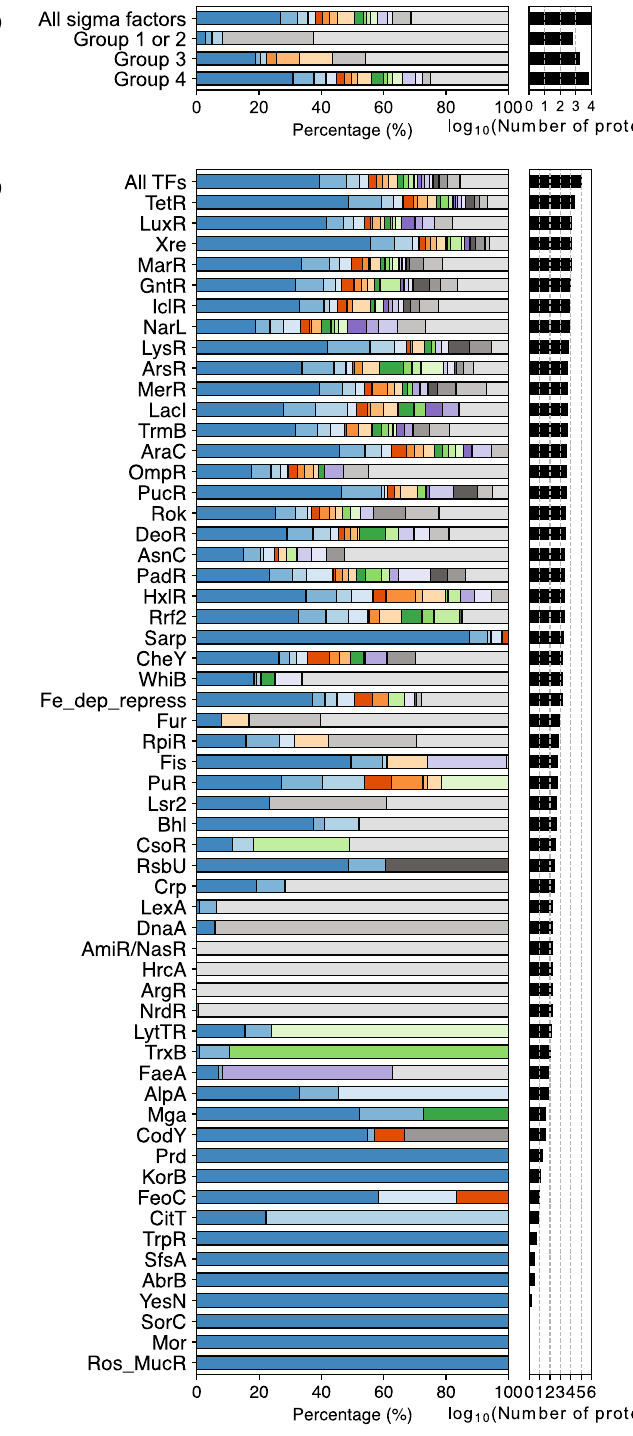
Figure 5. The total number of proteins in each sigma factor group ( A ) and other transcription factor family ( B ) and the percentage in each conservation bin. The colour codes are the same as those in Fig.